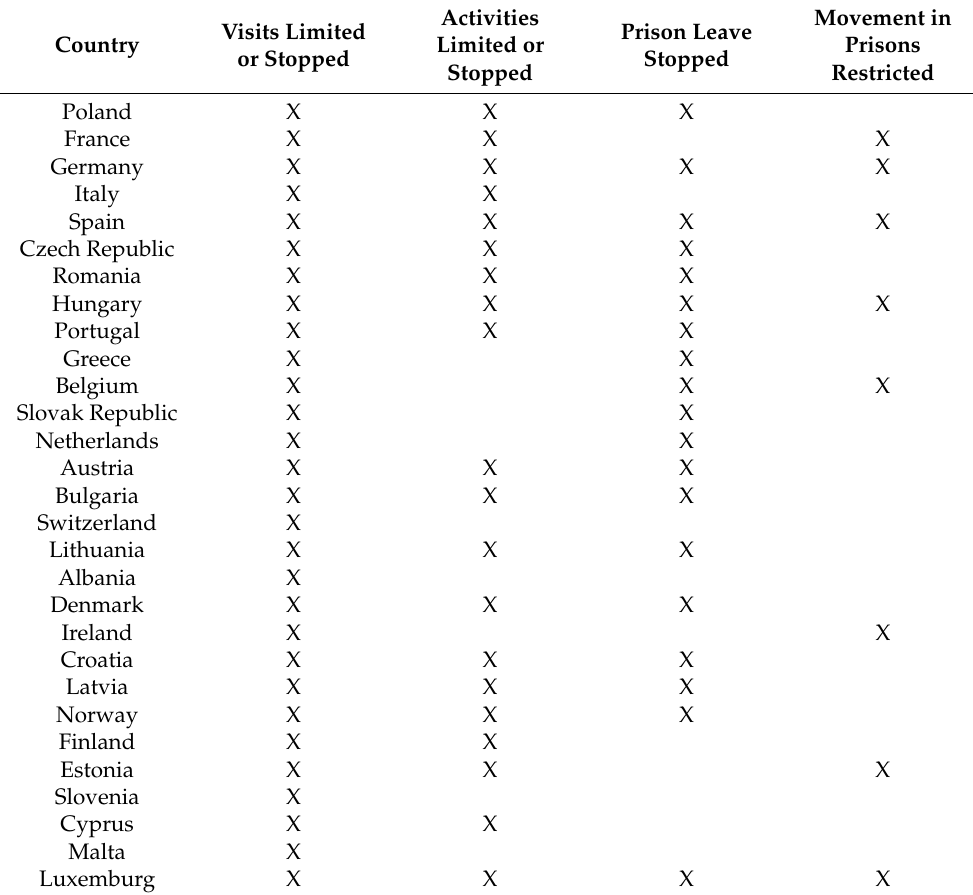
Table 1. Restrictive pandemic measures in prisons around Europe (symbol X indicates the restriction was introduced). Visits Limited Country or Stopped